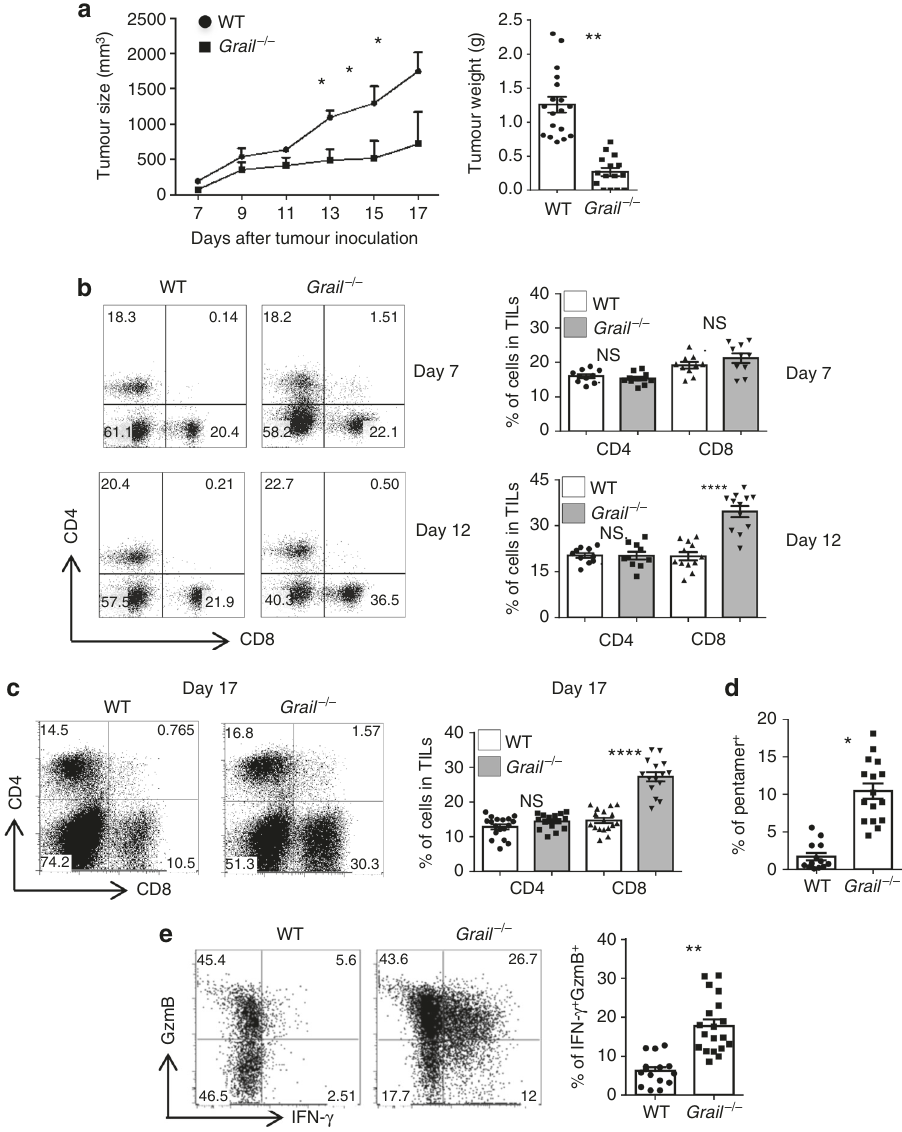
Fig. 1 EG-7 lymphoma growth is dramatically reduced in the absence of Grail. a WT and Grail − / − mice were injected with EG-7 tumour cells subcutaneously on day 0. Tumour growth was monitored from day 7 and calculated as ½ ( ab 2 ), where a is the length and b is the width. EG-7 tumour weight in WT and Grail − / − mice after euthanasia is shown on the right graph . ( n = 3 independent experiments with a total of 18 WT mice and 15 Grail − / − mice). b Tumour- in fi ltrating lymphocytes isolated from EG-7 tumours on days 7 and 12 were stained with anti-CD4 and CD8 α antibodies. Numbers in dot plot indicate the percentage of cells within each quadrant from a representative tumour at each time point. Individual mice per group are shown for each time point on the right bar graph . ( n = 10 mice per group from two experiments). c TIL were isolated from EG-7 tumours on day 17 and stained for CD4 + and CD8 + T cells as in b . The right bar graph shows the percentage of CD4 + and CD8 + T-cell subsets from individual mice per group. ( n = 18 WT mice and 15 Grail − / − mice from three independent experiments). d TILs were stained with an OVA-speci fi c pentamer and analysed in the CD8 + gate. ( n = 18 WT mice and 15 Grail − / − mice from three independent experiments). e TILs were stimulated for 5 h with OVA peptide, followed by intracellular staining of IFN- γ and granzyme B (GzmB) and analysed in the CD8 + gate. Numbers in dot plot quadrants represent the percentages of each marker. The percent expression of CD8 + IFN γ + GzmB + TILs per mouse is shown on the right bar graph . ( n = 18 WT mice and 15 Grail − / − mice from three independent experiments) * p < 0.05, ** p < 0.01, **** p < 0.0001, NS as determined using one-way ANOVA. NS not signi fi